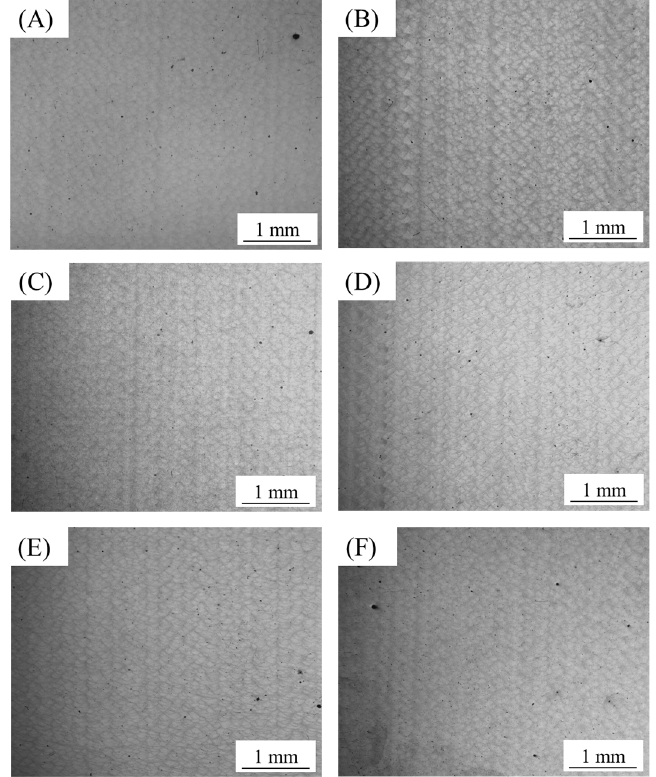
Figure 6. Optical micrographs of AlSi10Mg fabricated with hatch spacing of 0.18 mm and at different volume energy density, showing variation in porosity: ( A ) Process B1; ( B ) Process B2; ( C ) Process B3; ( D ) Process B4; ( E ) Process B5; ( F ) Process B6.